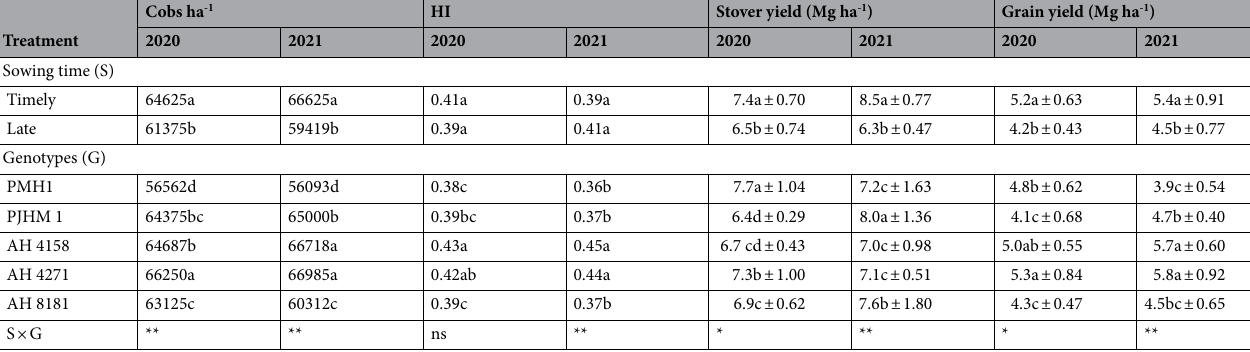
Table 1. Number of cobs, harvest index and yields of maize genotypes under timely and late sown conditions. Within sowing time and genotypes, different letters indicate the significant difference ( p ≤ 0.05 ); HI: Harvest index, The S × G implies the interaction between sowing time and genotypes; **Significant at p ≤ 0.01 ; *Significant at P ≤ 0.05 ; ns: not significant.